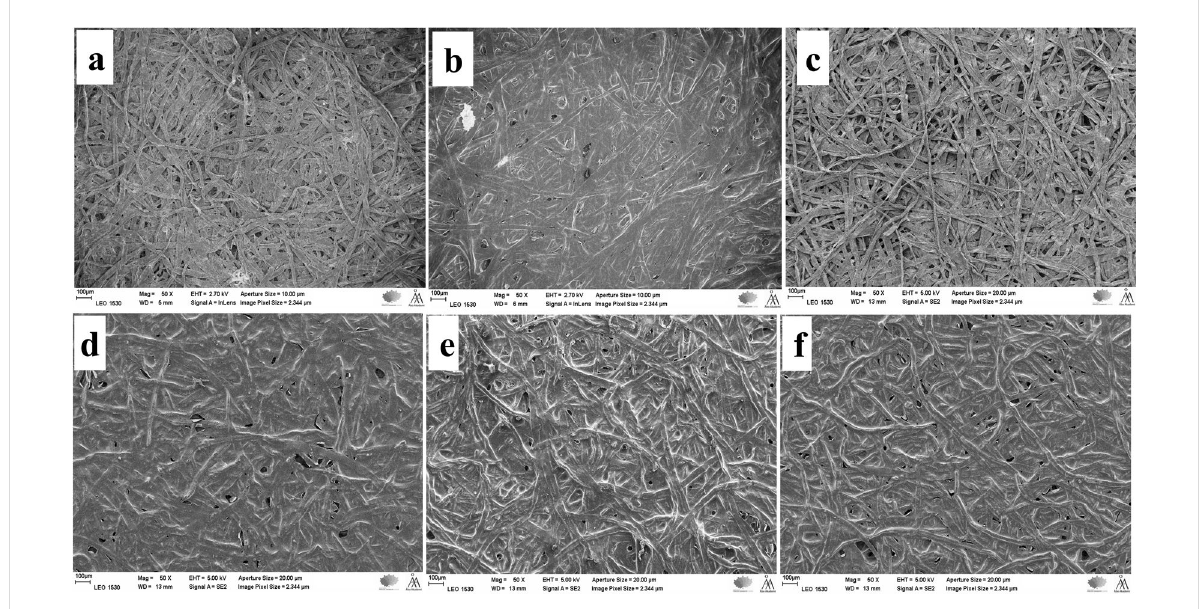
Figure 5: SEM images of the BKP fibers: (a) REF (b) C-F (c) HF (d) C-HF (0.15 M) (e) C-HF (0.30 M) (f) C-HF (0.45 M).